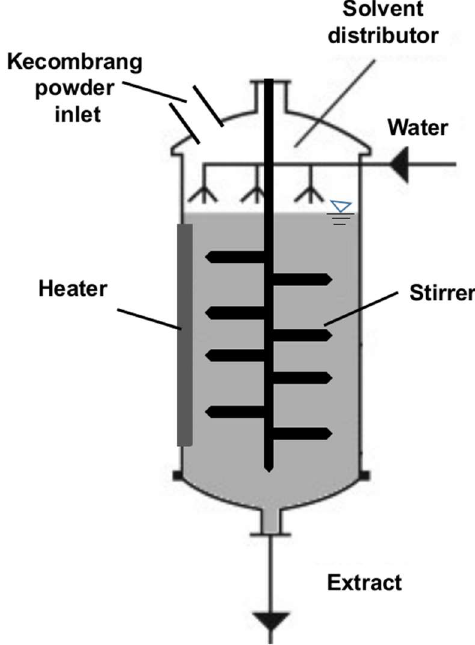
Figure 2. Industrial extraction machine.